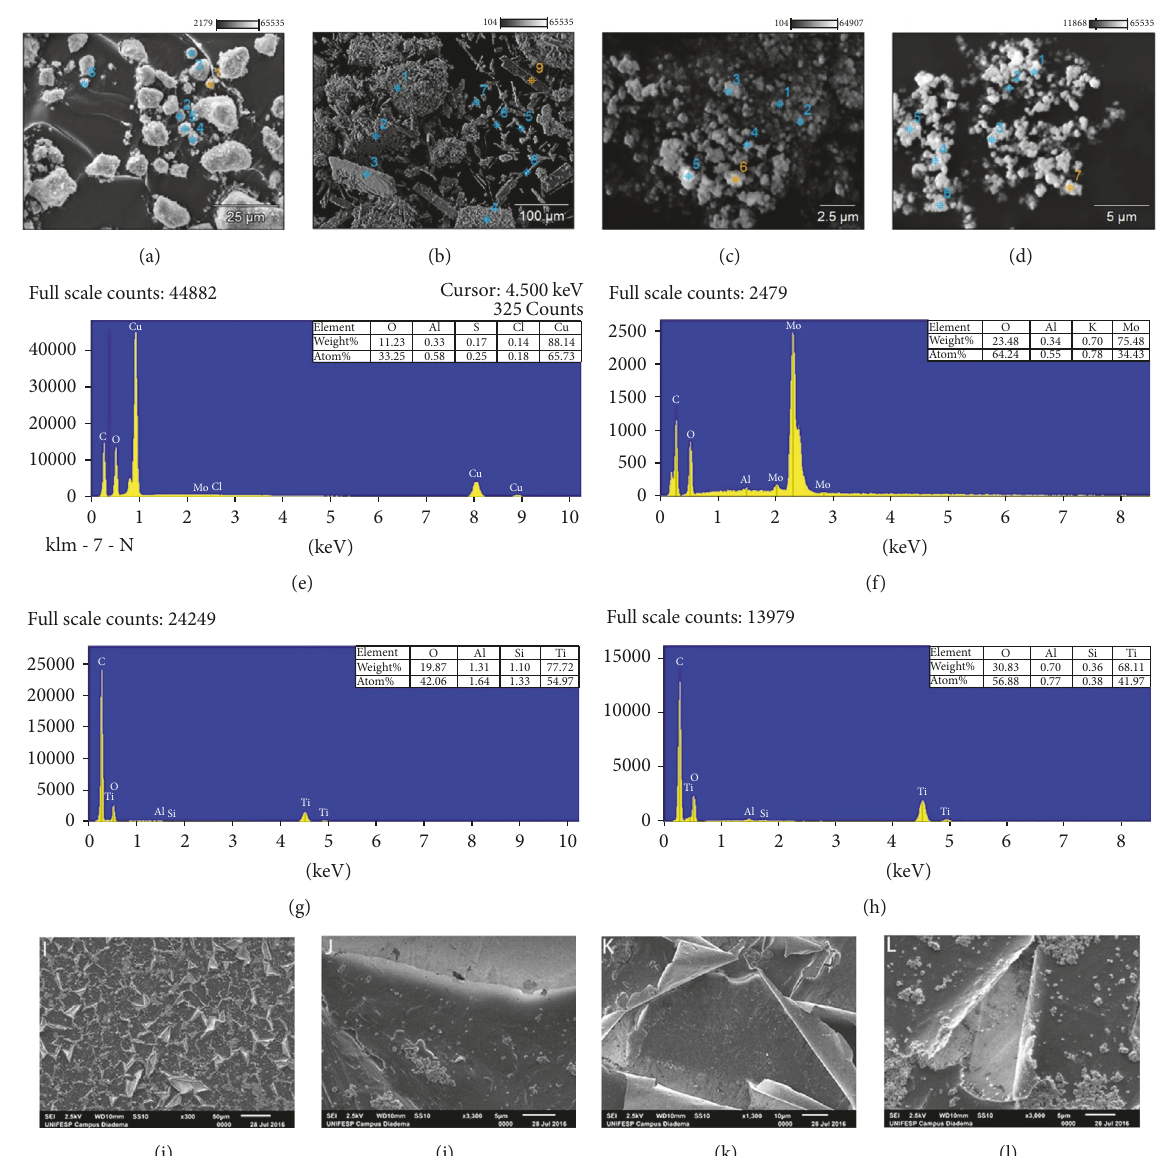
Figure 2: EDXMA analysis of metal oxides: Cu 2 O (a); MoO 3 (b); P25 (c); TiO 2 (d); Cu 2 O (e); MoO 3 (f); P25 (g); TiO 2 (h). SEM analysis of materials: B + P25 (i); M + TiO 2 (j); P + Cu 2 O (k); B + MoO 3 (l).